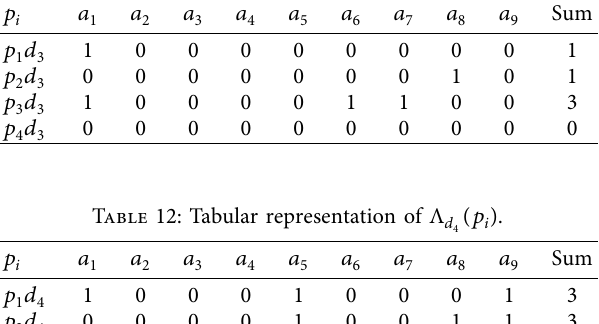
Table 11: Tabular representation of Λ